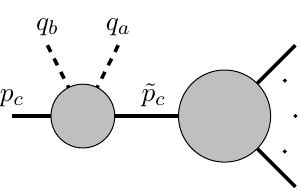
Figure 2 . Diagram containing potentially singular terms in the simultaneous double-soft